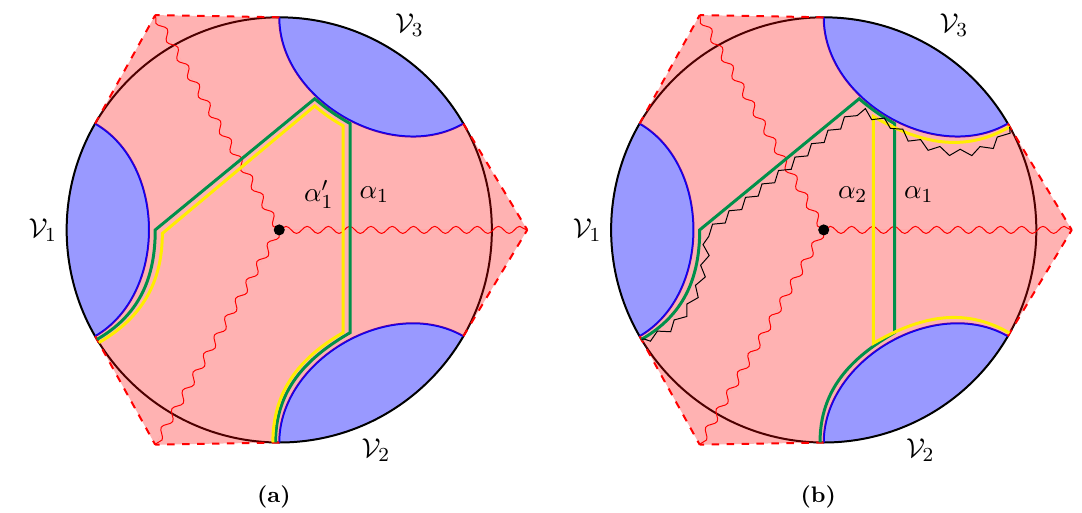
(yellow) that lies 1 (green) and α (yellow) intersect, then there 1 2 to the left endpoint of V that lies outside of 1 3